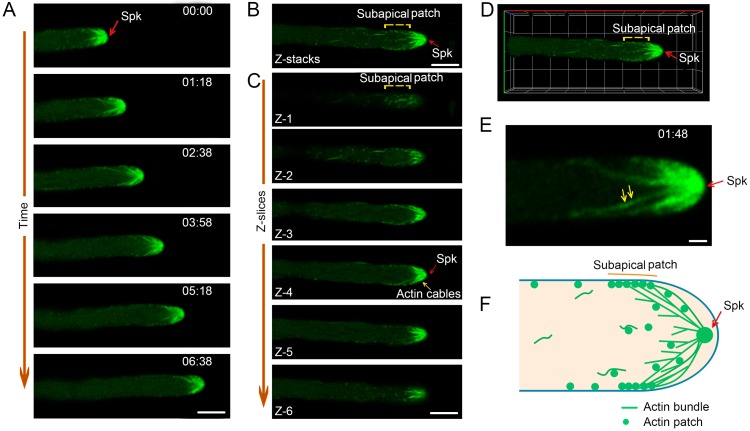
Organization of the actin cytoskeleton at the growing hyphal tip.(A) Time-lapse images illustrating actin distribution in the tip region of a growing hypha in liquid CM. The corresponding movie is provided as S1 Movie, which contains 200 frames. The numbers at the top right corner indicate the timestamps (min:s). Bar = 5 μm. (B) Maximum projection of Z-slices obtained by imaging a hyphal tip illustrating the structure of the actin cytoskeleton. Bar = 5 μm. (C) Z-slice images of (B) showing the distribution of subapical actin patches, actin cables, and actin at the Spk in an active hypha. (D) 3D image obtained from photographs in (B) and (C) showing the spatial structure of the actin cytoskeleton in the hyphal tip. The corresponding movie is provided as S2 Movie. (E) Time-lapse images (10 time points) showing the dynamic transport of patches along the actin bundle. The red arrows indicate the actin patches. The corresponding movie is provided as S3 Movie. Bar = 2 μm. (F) A proposed model showing the bowl-shaped organization of the actin cytoskeleton in the hyphal tip.